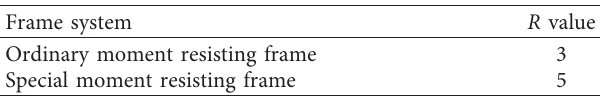
Table 1: Recommended values of the response reduction factor ( R ) by IS1893 (Part-1): 2016 [28].